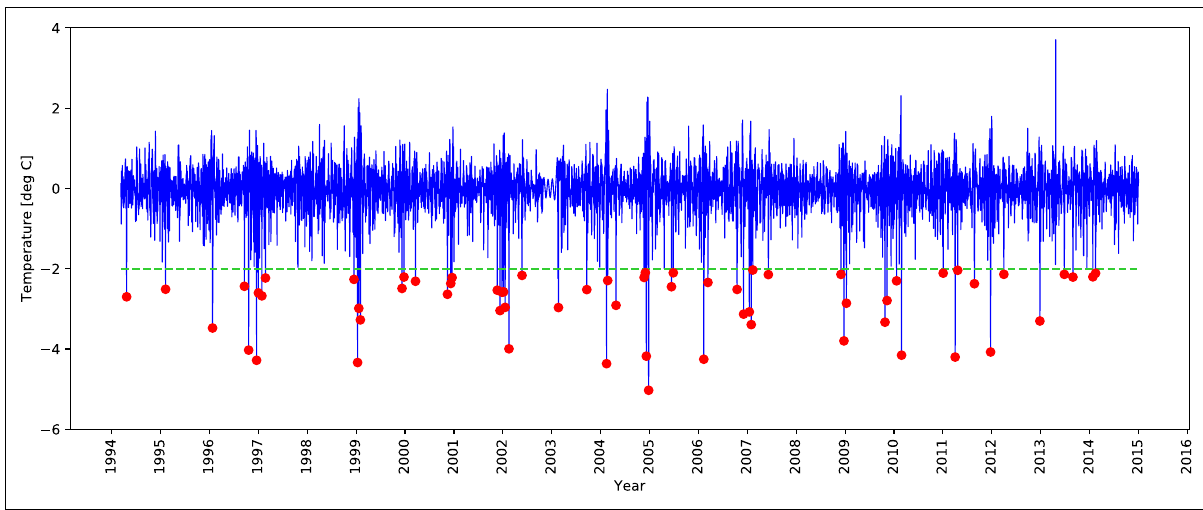
Figure 4: Filtered temperature signal on Nine-Mile Reef with the tidal and seasonal variance removed. Temporal positions of the temperature anomalies are denoted by red dots. The green dashed line presents the -2 °C threshold used for temperature anomaly